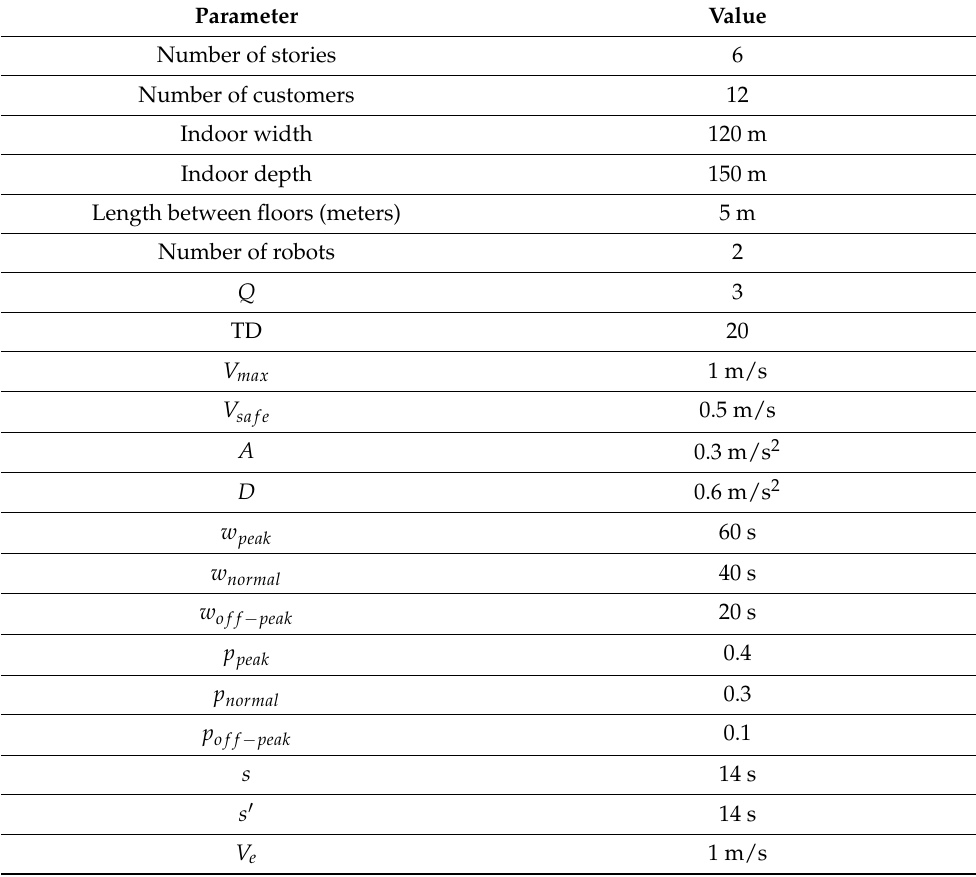
Table 4. System parameters of the numerical